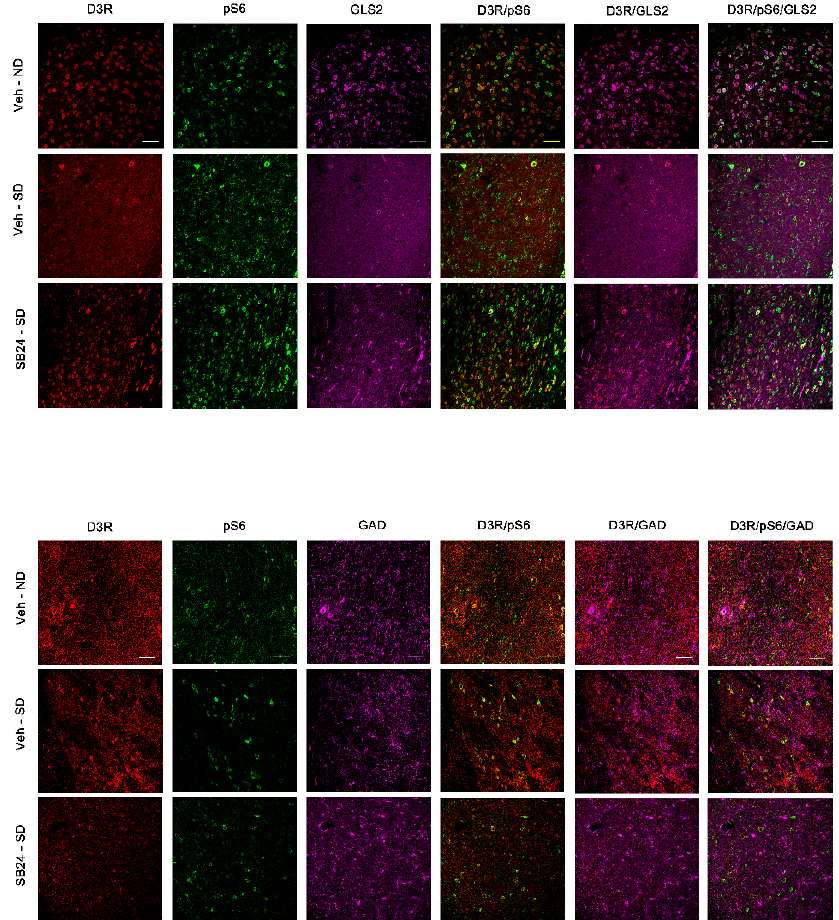
Figure 7. Representative confocal images showing the basolateral amygdala coronal sections im- munostained for dopamine type 3 receptor (D3DR, red), phosphorylated S6 protein (activated; green), GLS2 (magenta, glutamatergic neurons), and GAD (magenta, GABAergic neurons) from controls (veh-ND), from mice exposed to a social defeat agonistic encounter after 60 days of abstinence (veh-SD) and from mice receiving an injection of the D3DR antagonist SB-277011-A (24 mg/kg i.p.) prior to the social-defeated agonistic encounter after 60 days of abstinence (SB24-SD). Colocalization of D3DR/GLS2, pS6/GLS2, DRD3/pS6/GLS2, D3DR/GAD, pS6/GAD, and DRD3/pS6/GAD are also shown in the figure. Scale bars: 50 μ m.